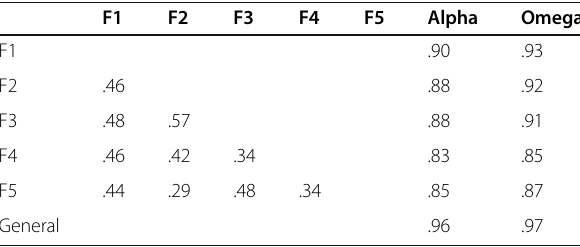
Table 6 Correlations between the latent factors from the EFA, Cronbach ’ s alpha, and McDonald omega for each dimension and general factor